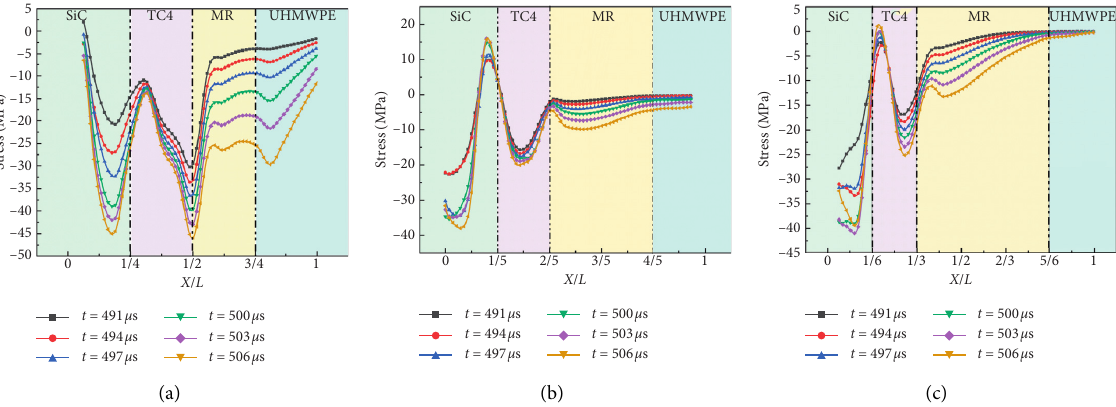
Figure 11: Structure IV with different MR thicknesses: (a) 5 mm MR; (b) 10mm MR; (c) 15mm MR.